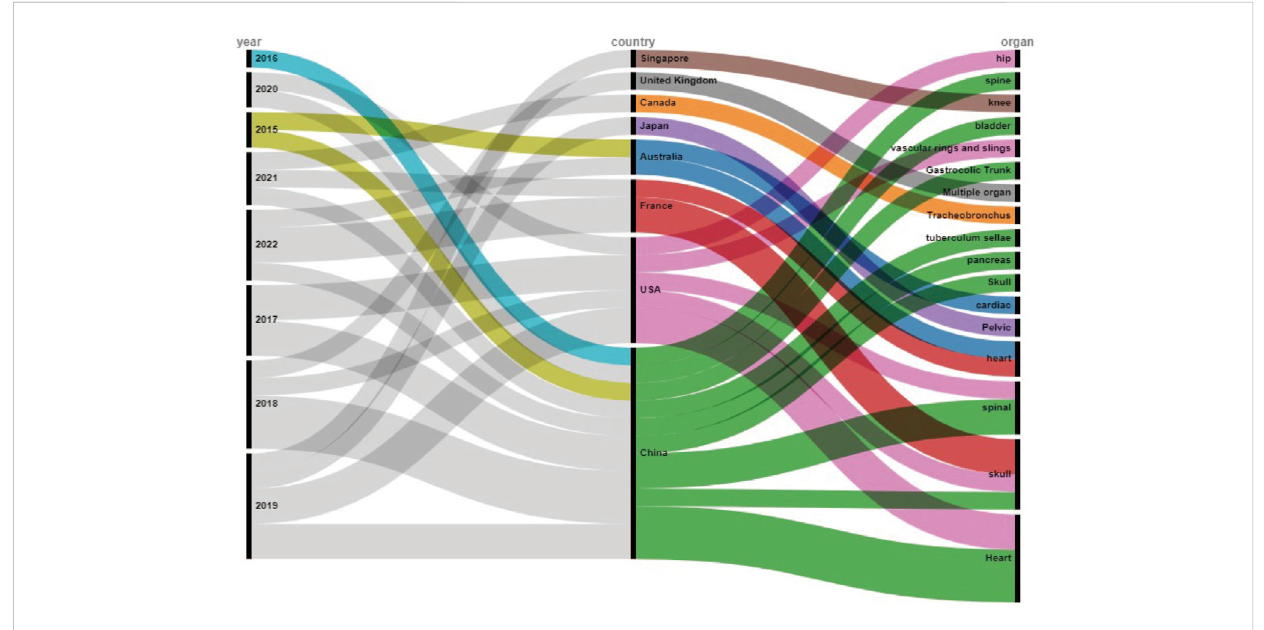
FIGURE 2 Alluvial diagram of the 27 articles included in this